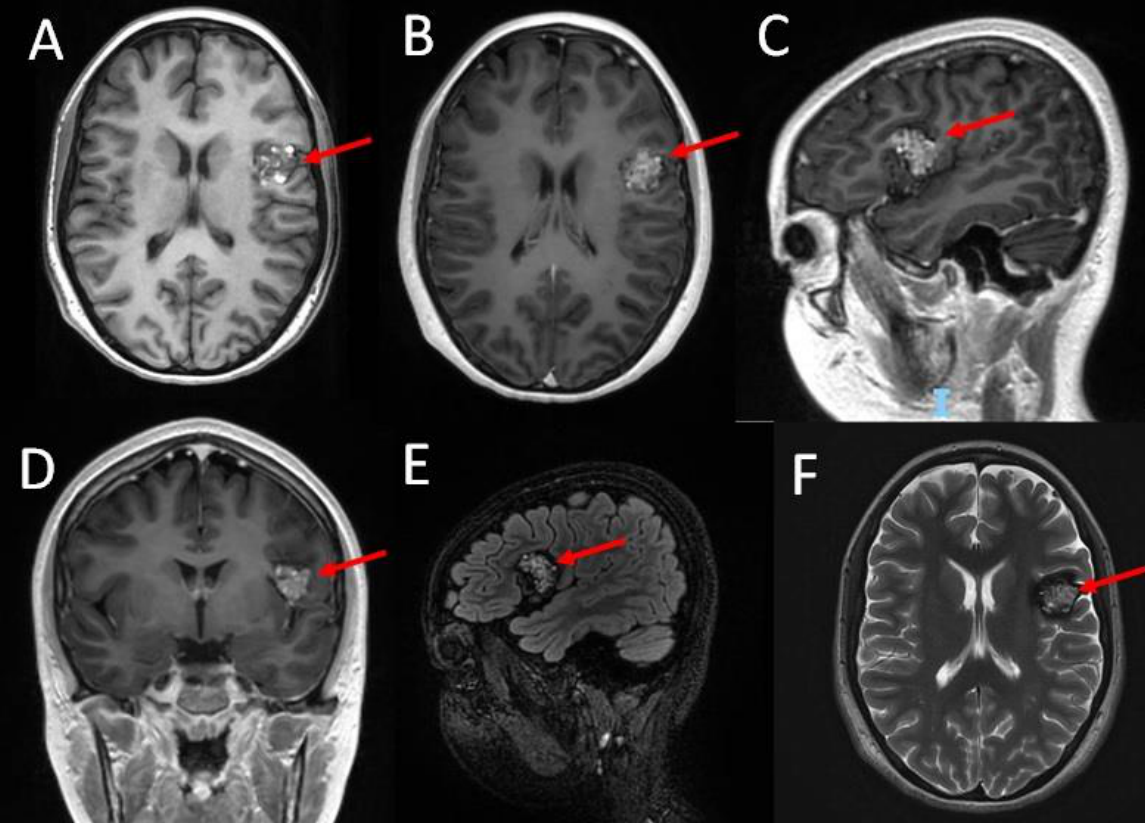
Figure 1 – Pre operative MRI showing lesion (red arrow) aspect in T1-weighted sequences, axial non contrasted (A), axial contrasted (B), sagittal contrasted (C) and coronal contrasted (D). Flair Sagittal (E). T2 axial (F).